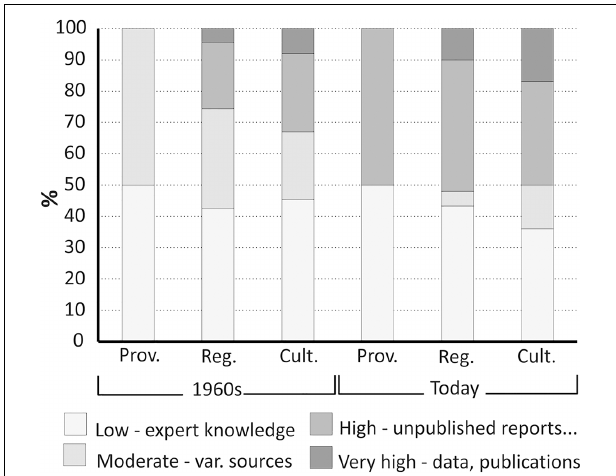
FIGURE 6 | Type and quality of information sources used in the ES assessment in the Schlei Estuary. The assessment includes the indicators of 22 ES classes. For indicators of 9 ES classes no data could be